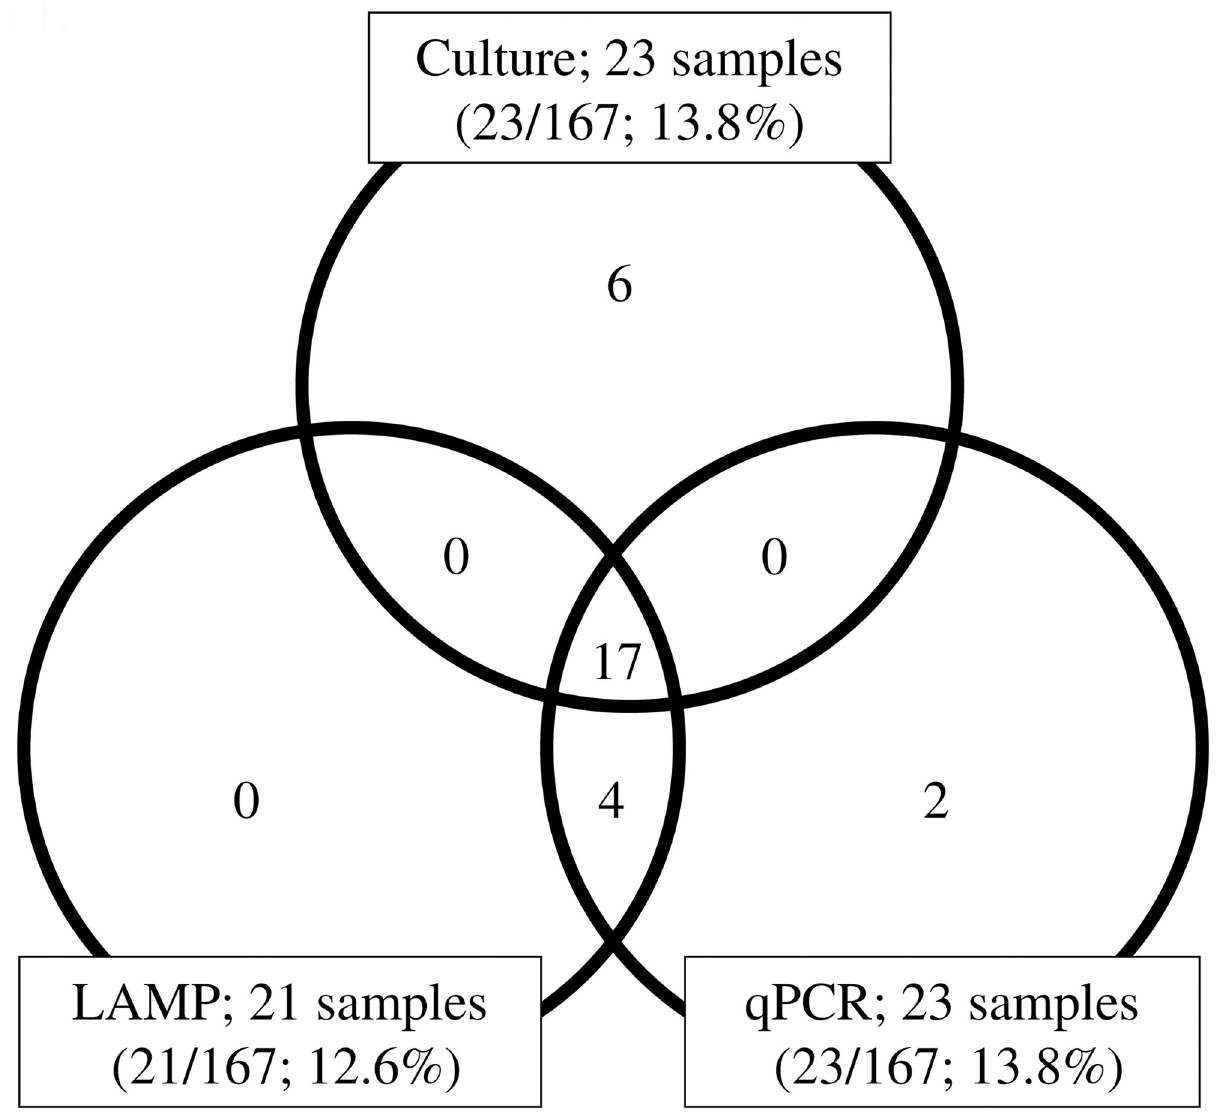
Fig 1. Detection of Ureaplasma species in nasopharyngeal swabs analyzed by culture, LAMP, and qPCR. In each field of the venn diagram, the number of samples positive for Ureaplasma species is given. LAMP; Loop-mediated isothermal amplification. qPCR; Quantitative real-time PCR.